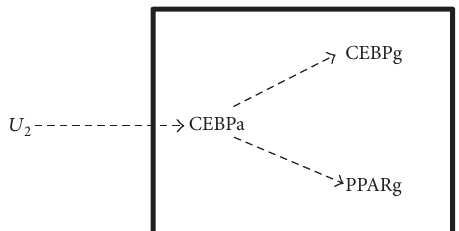
Figure 5: Window #2 optimal regulatory relationship. Expression profiles of all three genes showed nonzero lags (CEBPa (6 hours), CEBPg (6 hours), and PPARg (12 hours)). Between the two genes with shortest lags, CEBPa showed a better fit with external input 𝑈 . The input 𝑈 was a sigmoid function to produce a delayed response in the activity of gene CEBPa. Parallel and serial regulatory rela- tionships were tested and the above optimal regulatory relationship yielded the smallest BIC